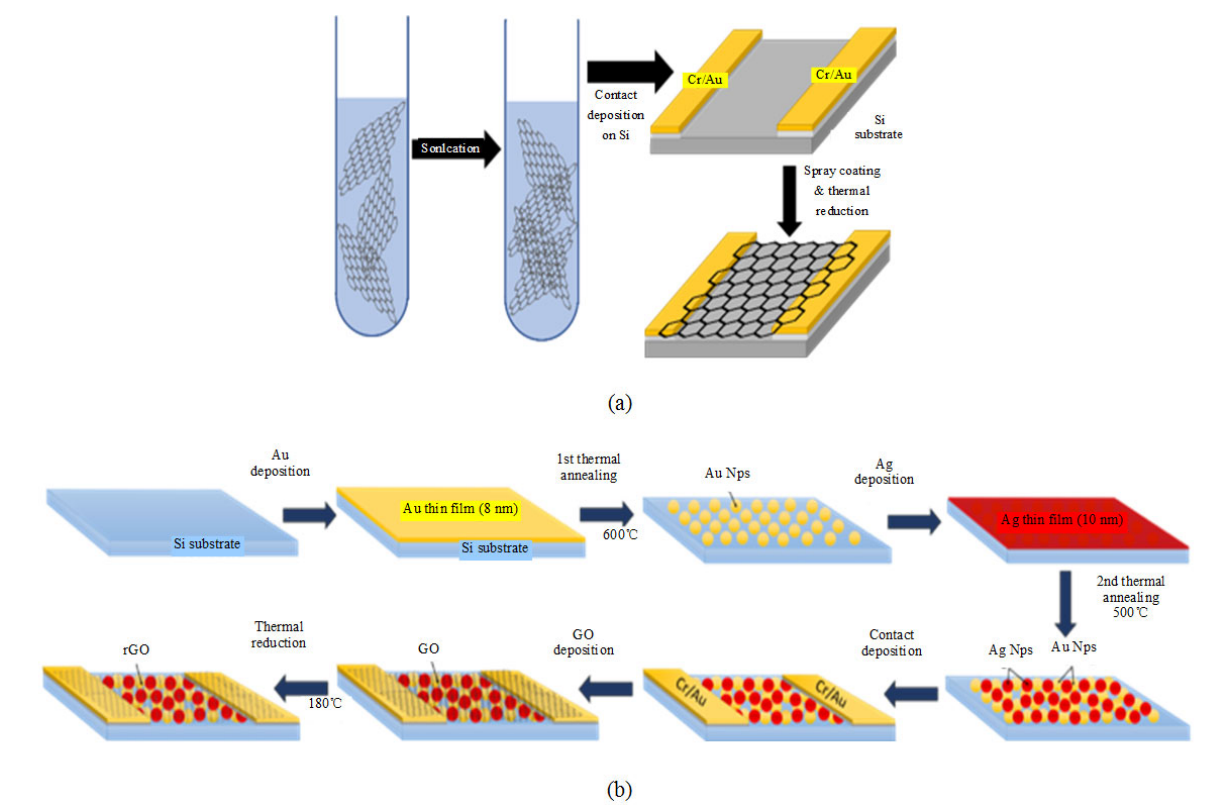
Fig. 1 Steps of fabrication process from (a) GO solution deposited on the substrate via spray deposition technique and (b) process of deposition thin layer, to formation of the NPs and